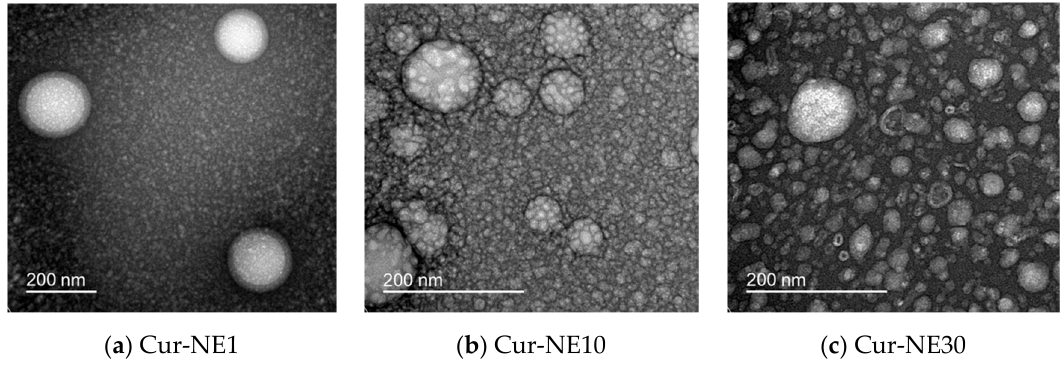
Figure 2. Transmission electron microscope images of Cur-NE1 ( a ), Cur-NE10 ( b ), and Cur-NE30 ( c ) taken immediately after synthesis. The scale bar is 200 nm in each image.